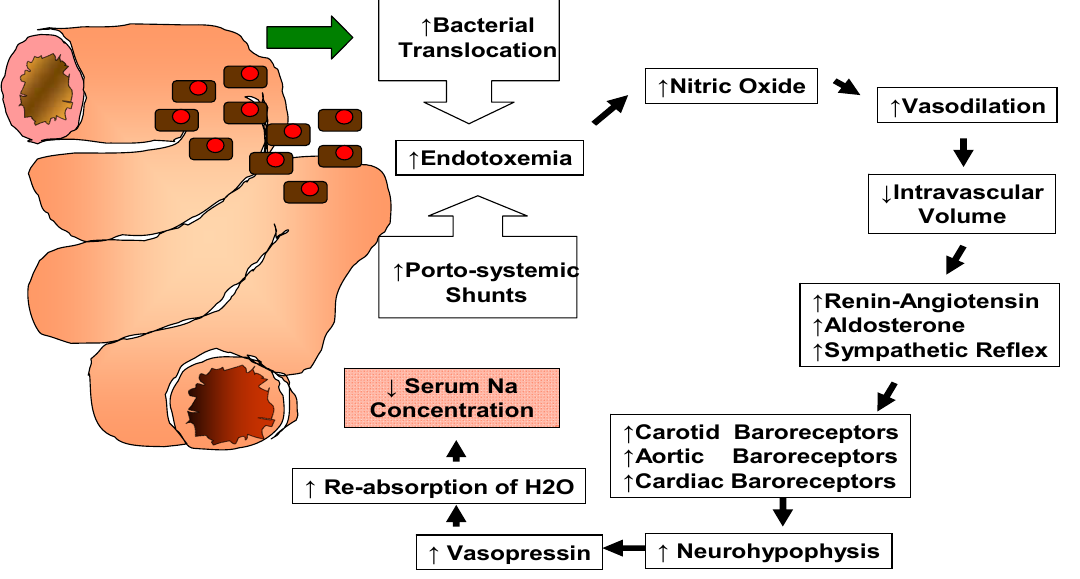
Figure 1. Pathophysiology of dilutional hyponatremia in patients affected by end stage liver